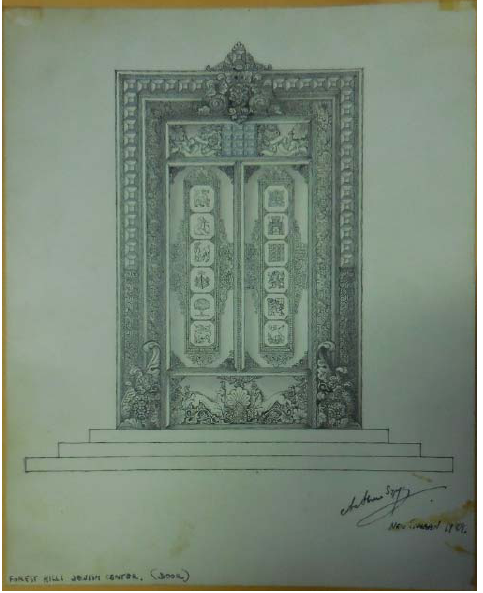
Figure 4. Arthur Szyk, ink sketch for the ark doors, 1949.